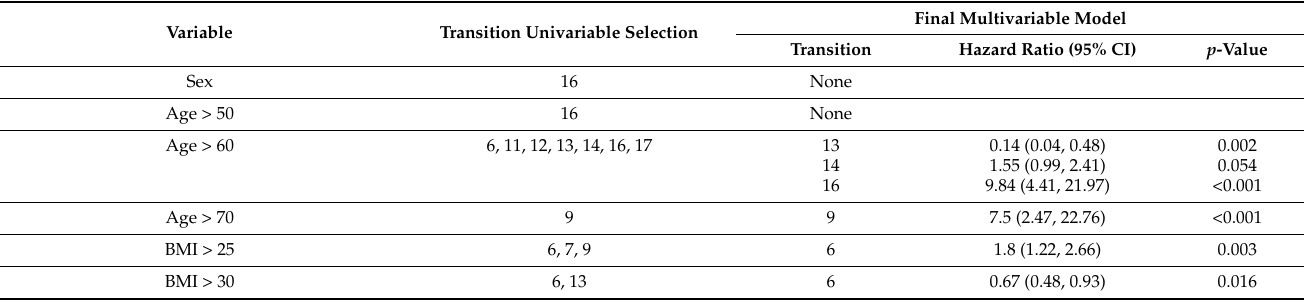
Table 2. Results in term of univariable analysis and final multivariable